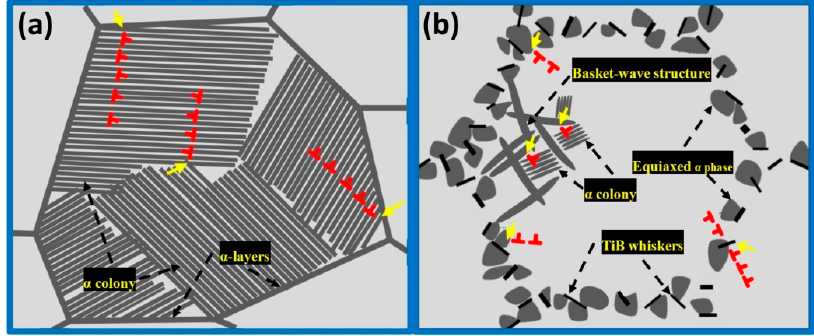
Figure 12. Schematic illustration of dislocation pile-up: ( a ) TA15; ( b ) TiBw/TA15 composites.